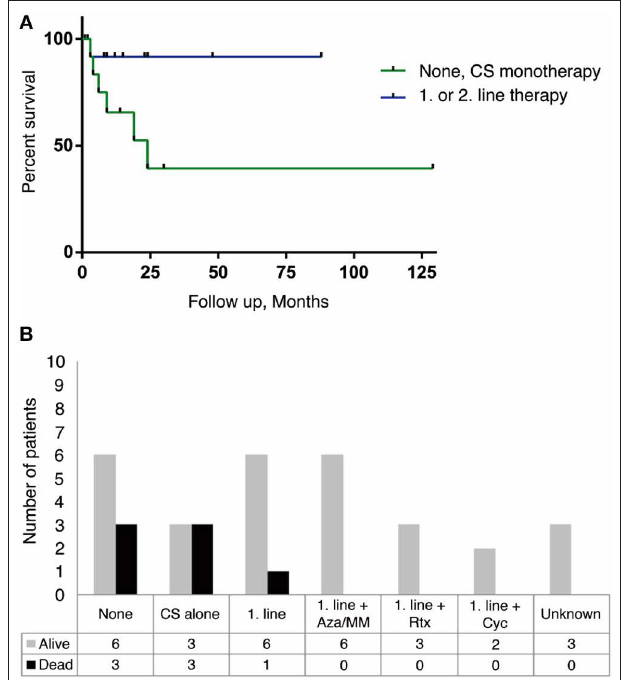
FIGURE 2 | Treatment strategies and survival outcome in anti-IgLON5 disease. Patients receiving no therapy or CS monotherapy had a higher mortality than patients treated with a combination of 1. line therapy (CS + IVIg or TPE or IVIg/TPE alone) and a steroid sparing agent. Similarly, addition of 2. line therapy with Rituximab or cyclophosphamide improved survival. (A) Kaplan-Meier survival curve showing the difference in survival between no therapy and/or CS alone (green line) and 1. or 2. line therapy (blue line). It should be noted that follow-up time differed from case to case, resulting in a high number of censored data (black dot) within an already small population ( n = 27, p = 0.064). (B) Outcome between different treatment strategies n = 36. CS, corticosteroids; IVIg, intravenous immunoglobulin; TPE, therapeutic plasma exchange; Aza, Azathioprine; MM, Mycophenolate Mofetil; Rtx, Rituximab; Cyc,